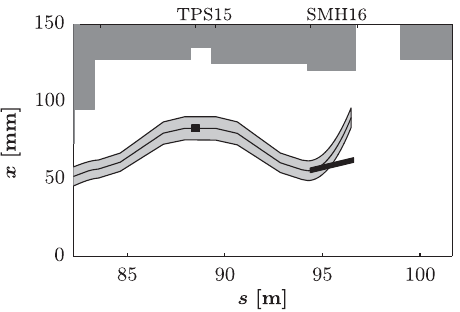
FIG. 21. During the rise time of the fast extraction kickers, the beam is swept from the internal to the external side of both TPS15 and SMH16. Proper adjustment of the positions (and angles) of both septa allows to put SMH16 in the shadow of TPS15, and, therefore, reduce the losses in SS16. In the shown configuration the black rectangles indicate the septa at properly adjusted positions to provide shadowing. The efficiency of the shadowing might, however, be different between the core and the islands.